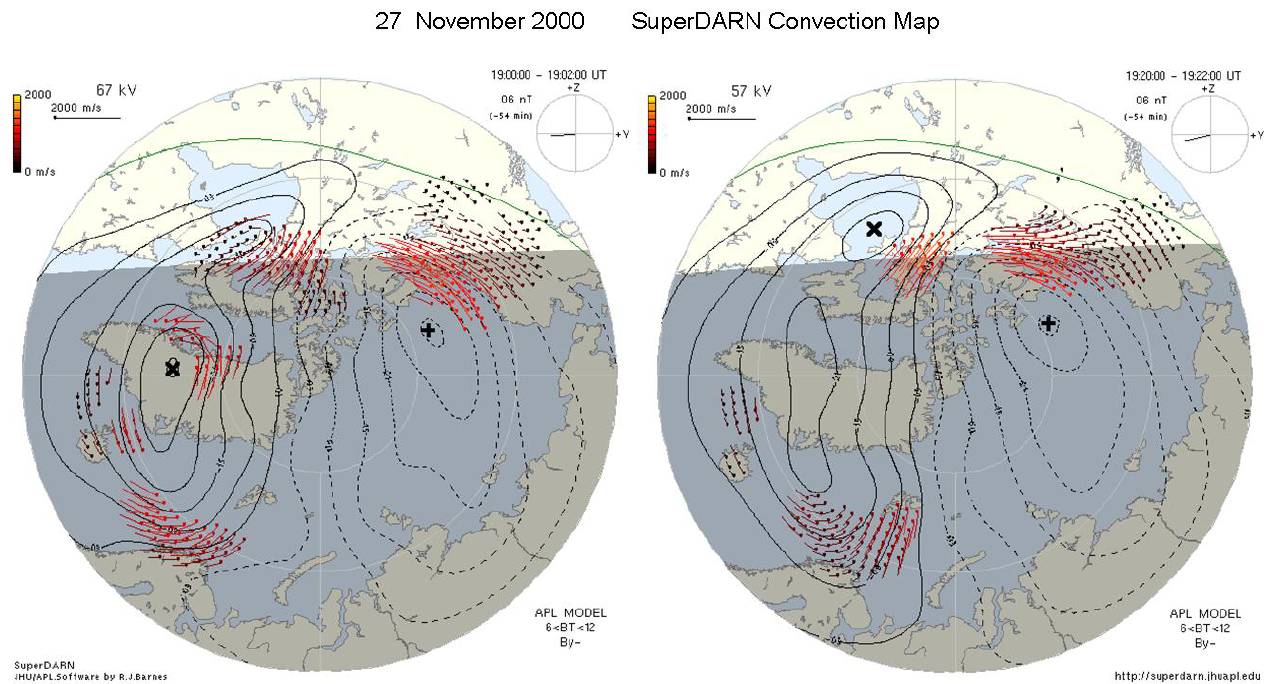
Fig. 5. SuperDARN plasma convection data are shown for 19:00:00–19:02:00UT (left) and 19:20:00–19-22:00UT (right).